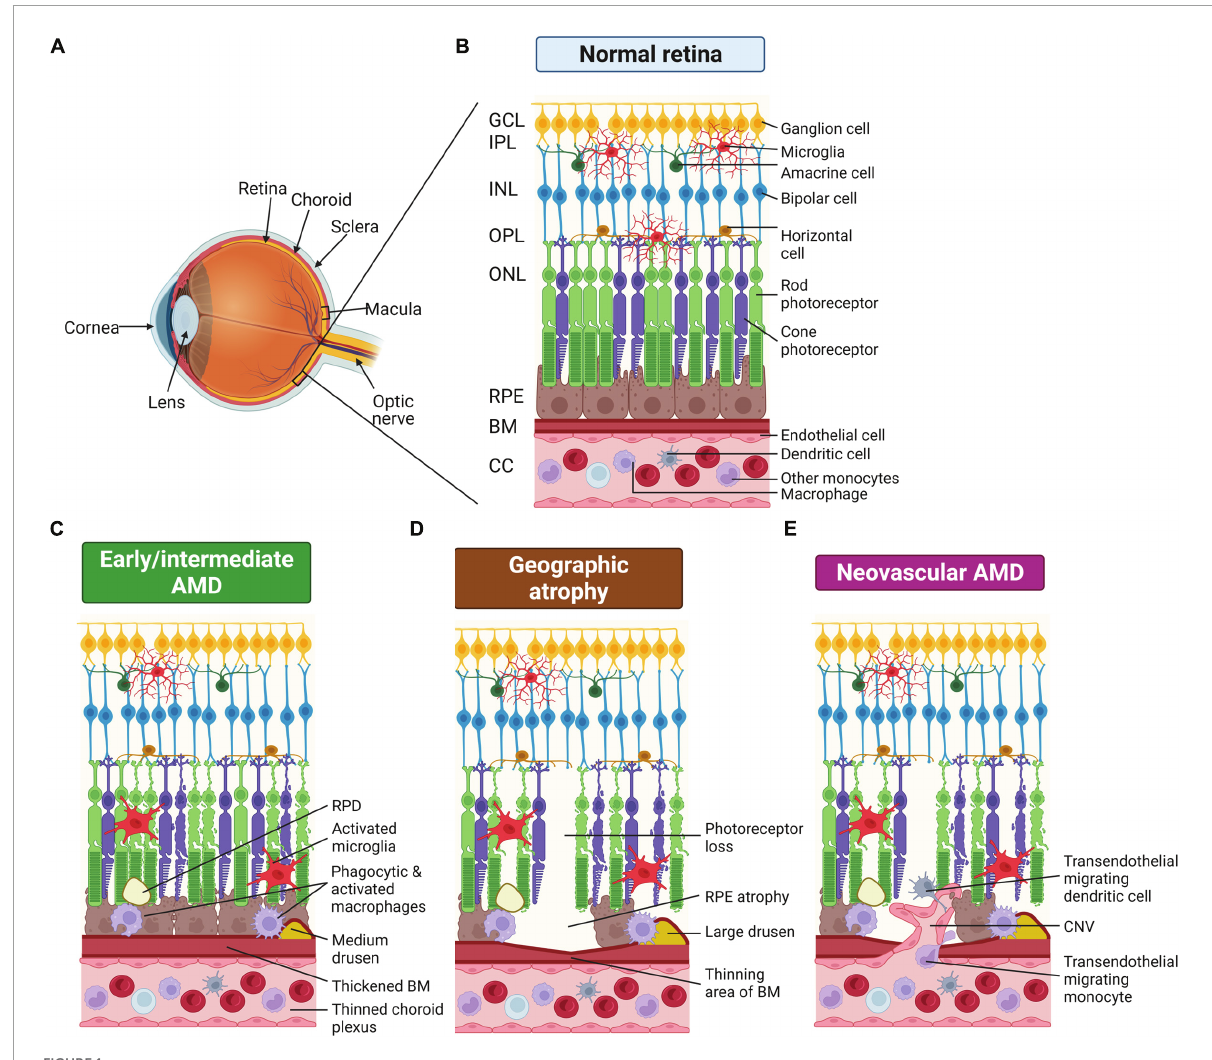
FIGURE1 Schematic of changes that occur in the eye of age-related macular degeneration (AMD) patients. (A) Schematic render of the eye showing posterior ocular tissues affected in AMD, expanded in subsequent panels. (B) Healthy posterior eye, showing transverse section of the retinal layers, the retinal pigment epithelium (RPE), Bruch’s membrane (BM), and vascular supply (the choriocapillaris, CC). The location of the mononuclear phagocytes (MPs) is indicated including retinal tissue resident microglia associated with the neuronal synaptic layers (nerve fiber layer MPs not shown) and MPs in the choroid, including dendritic cells, macrophages and other monocytes. (C) Schematic of early/intermediate AMD showing thickening of BM, deposition of extracellular waste around the RPE (drusen and reticular pseudodrusen, RPD), thinned choroid, and changes in MPs, including activation of microglia within the retina. (D) Schematic of late-stage AMD, geographic atrophy, showing loss of photoreceptors and RPE cells, thinning of BM in regions of cell loss, and deposition of large drusen. Microglia within the retina are activated and activated macrophages on the choroidal side are associated with the damaged basal RPE/BM. (E) Schematic of late-stage neovascular AMD showing choroidal neovascularization (CNV), loss of photoreceptors and RPE cells, thinning of BM in regions of cell loss and deposition of large drusen. Microglia within the retina are activated and peripheral circulating monocytes and dendritic cells are activated and associated with damaged RPE and are also able to enter the retina via new leaky vessels. This illustration was started from a BioRender Template and content and stylistic modifications were